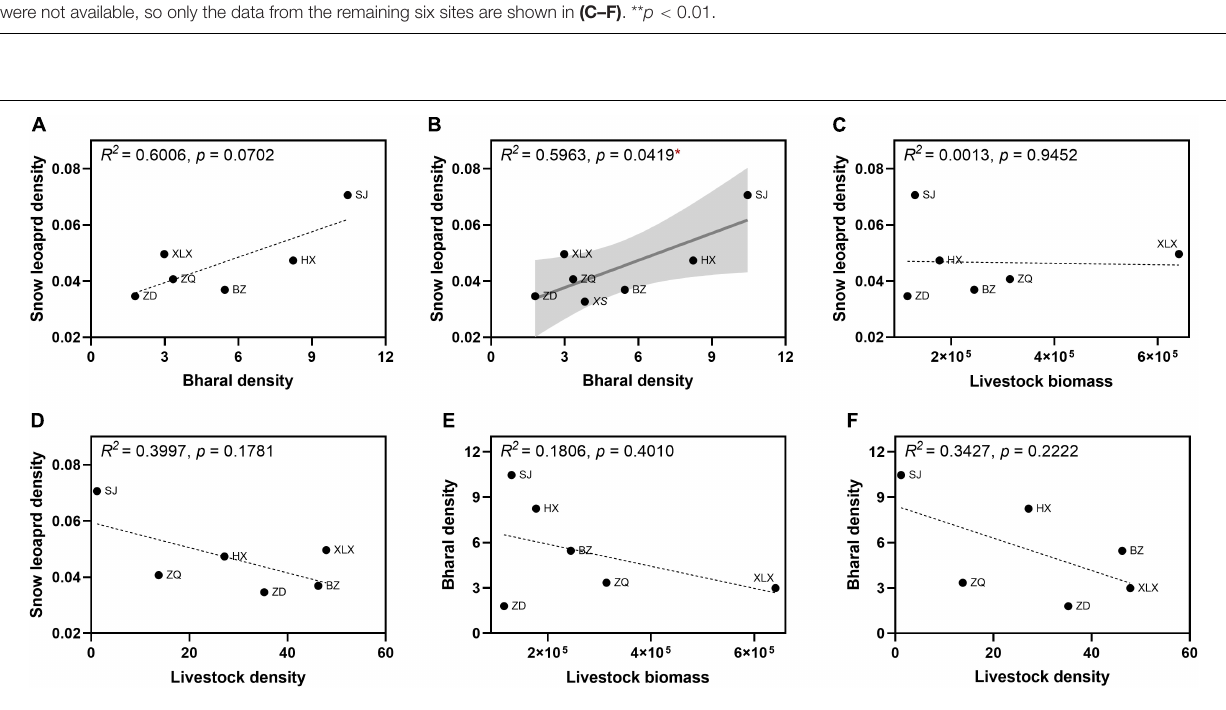
Frontiers in Ecology and Evolution |